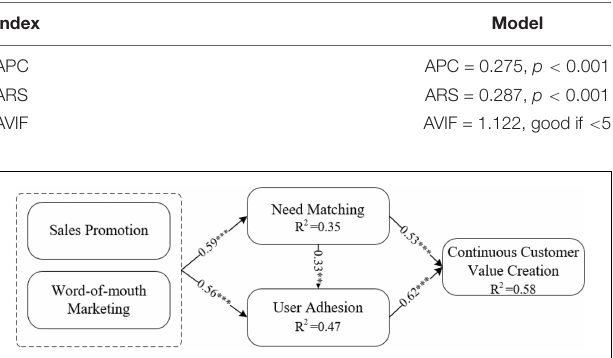
TABLE 1 | Model fit indices and P -values.